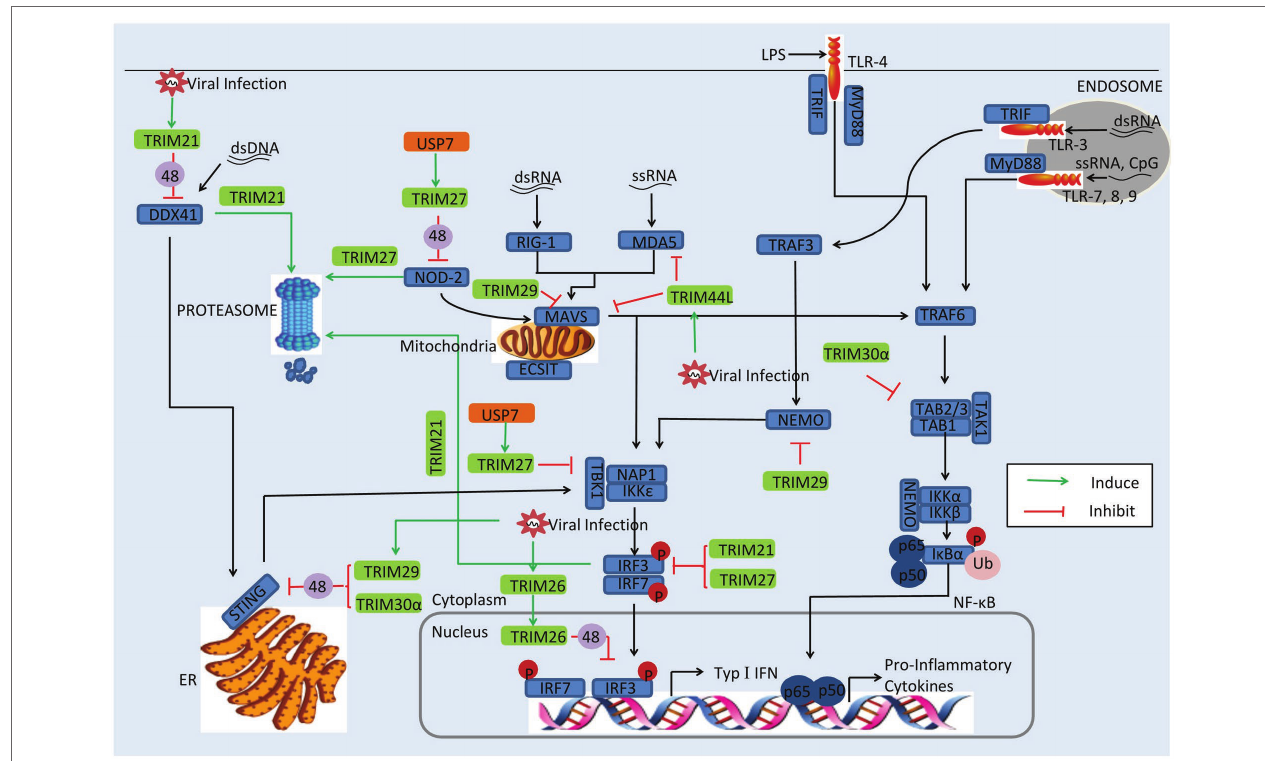
FIGURE 3 | Viral evasion of immune response via induction of TRIMs. Some TRIMs (green) negatively regulate innate immune response. Viral proteins (orange) can utilize these TRIMs to reduce the production of type I IFNs and inflammatory factors. USP7, the ubiquitin-specific peptidase 7 of SeV; 48, K48-linked polyubiquitination; and 63, K63-linked